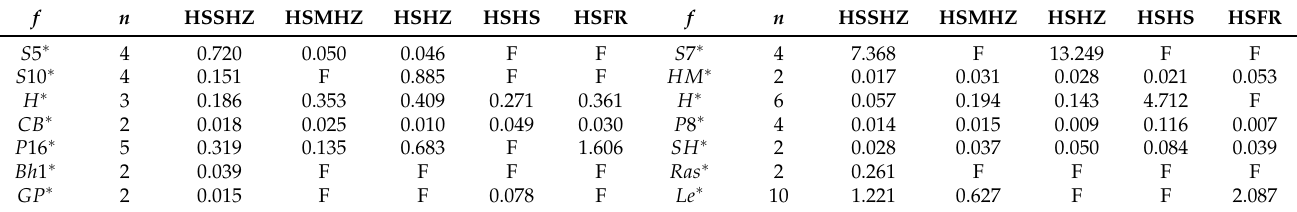
Table 13. The average of time.